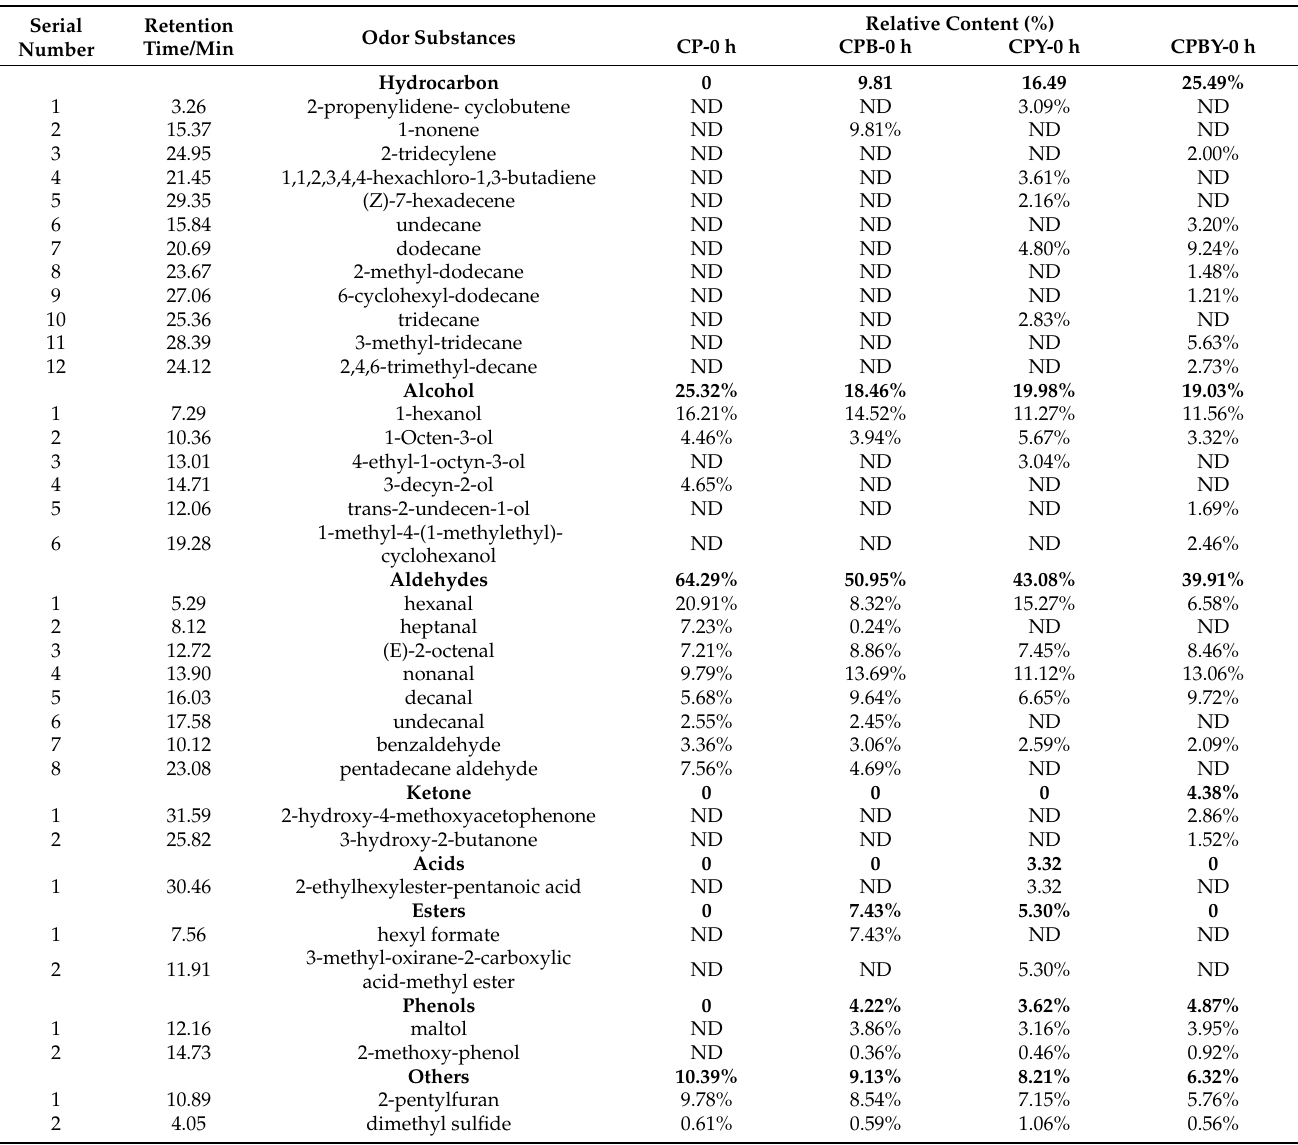
Table 2. Volatile odor substances in four groups of unfermented